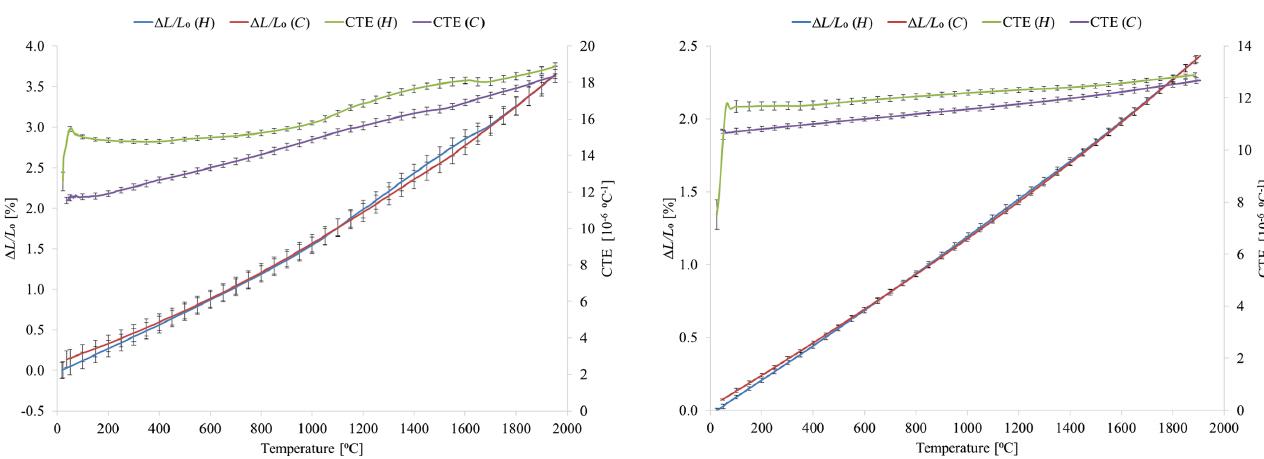
FIG. 12. Relative change in length and CTE against temper- ature with initial thermal reference of 48 °C ( H ) and 50 . 1 °C ( C ) for MoGr along ( T ).